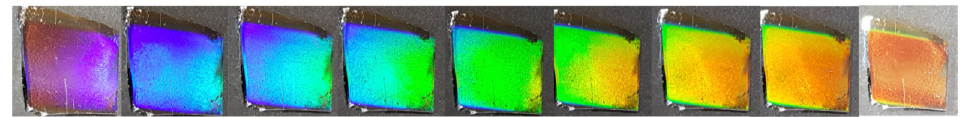
Figure 6. Optical images, obtained under different angles of white light illumination, of 1 × 1 cm 2 nanostructured samples obtained by using the sequential nanosecond pulsed laser irradiation.